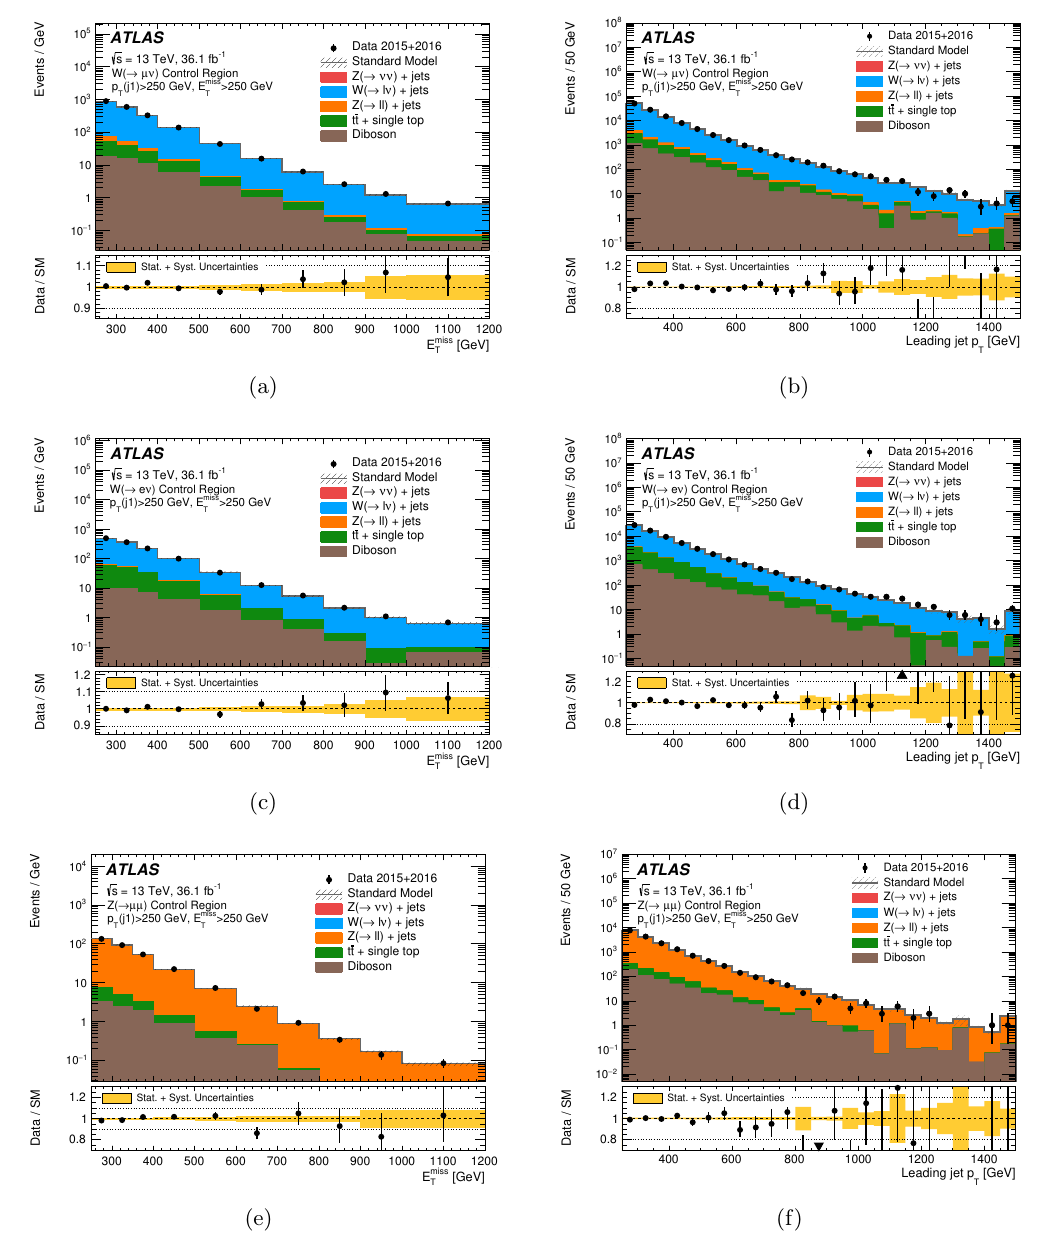
and (b),(d),(f) leading-jet p T distributions in the Figure 2 . The measured (a),(c),(e) E miss T W ( ! (cid:22)(cid:23) )+jets, W ( ! e(cid:23) )+jets, and Z=(cid:13) (cid:3) ( ! (cid:22) + (cid:22) (cid:0) )+jets control regions, for the E miss > 250 GeV T inclusive selection, compared to the background predictions. The latter include the global nor- malization factors extracted from the (cid:12)t. The error bands in the ratios include the statistical and systematic uncertainties in the background predictions as determined by the binned-likelihood (cid:12)t to the data in the control regions. The last bin of the E miss and leading-jet p T distributions contains T over(cid:13)ows. The contributions from multijet and non-collision backgrounds are negligible and are not shown in the